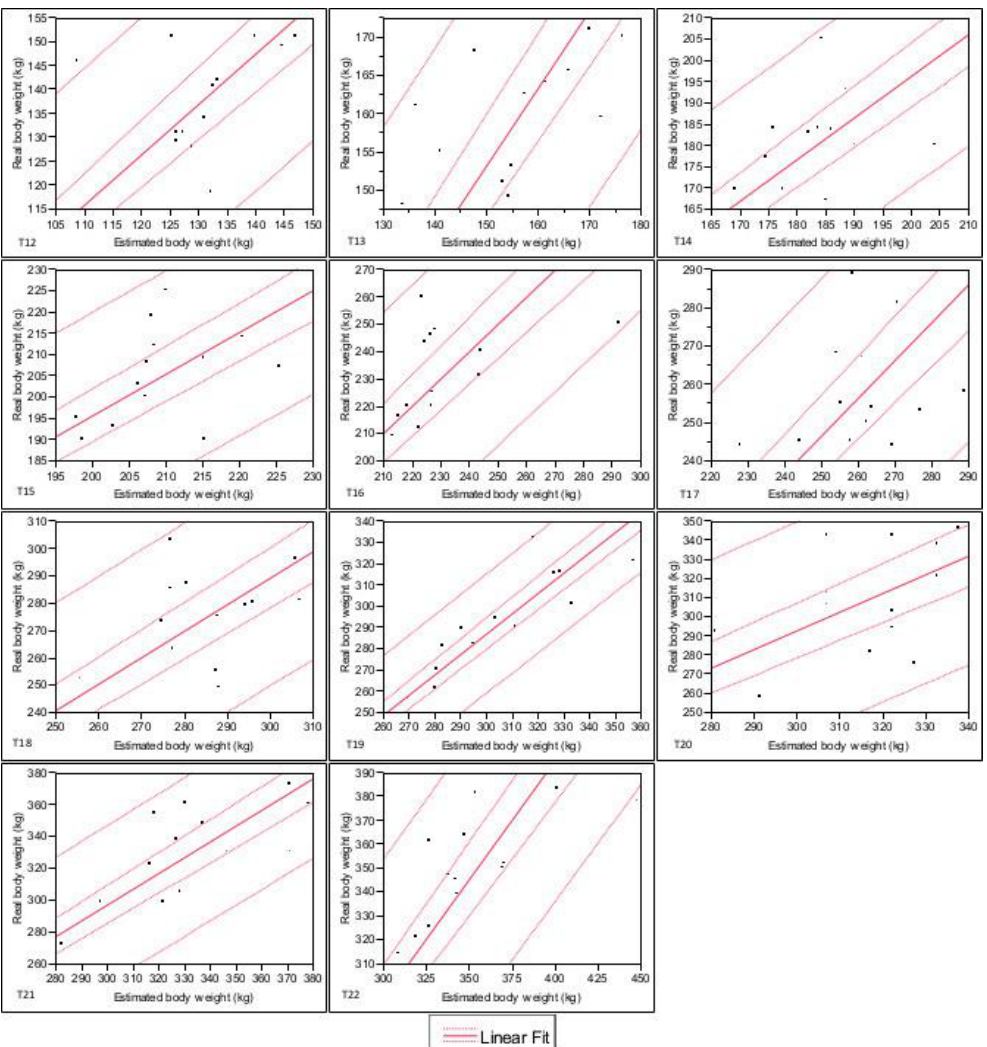
Figure 2. Confidence interval regarding relationship between real body weight and estimated body weight investigated from T12 to T22. Internal dashed lines = Prediction lines. External dashed lines = Confidence lines. Legend: T12: 5 months old, T13: 6 months old, T14: 7 months old, T15: 8 months old, T16: 9 months old, T17: 10 months old, T18: 11 months old, T19: 12 months old, T20: 13 months old, T21: 14 months old, T22: 15 months old.